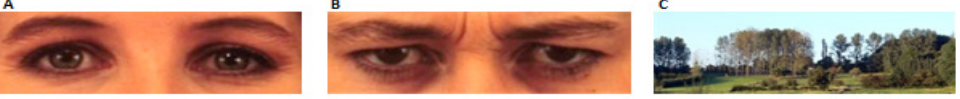
Figure 2. The two types of eye cues, kind eyes ( A ) and unkind eyes ( B ), and the control cue ( C ).